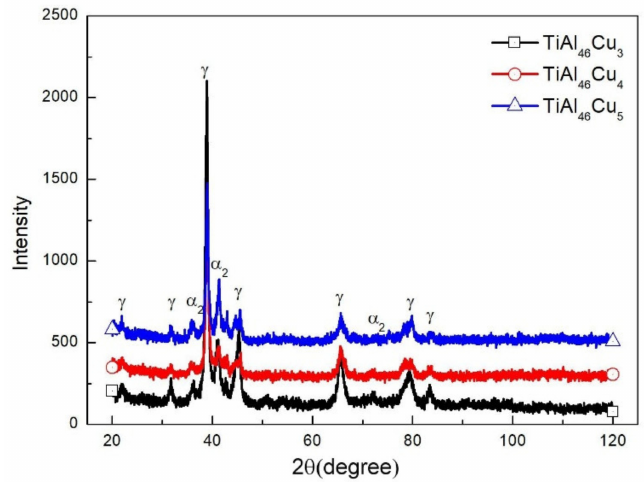
Figure 1. XRD patterns of TiAl 46 Cu x specimens with x = 3, 4 and 5